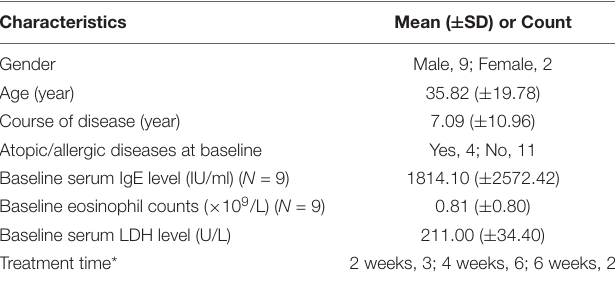
FIGURE 3 | Real world data on EASI 50, EASI 75, and EASI 90 from different countries. TABLE 5 | The characteristics of eleven patients had a poor curative effect on